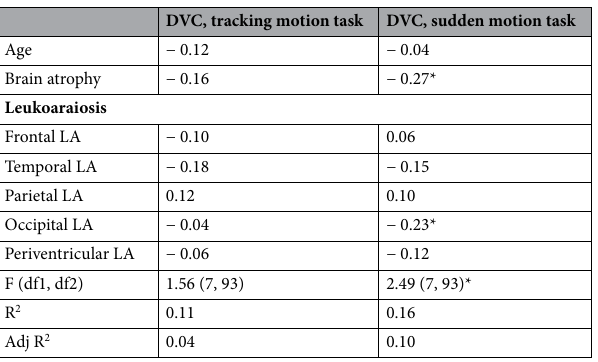
Table 5. Relationship between leukoaraiosis volume and DVC scores. LA leukoaraiosis, DVC dynamic visual cognition; * p < 0.05.